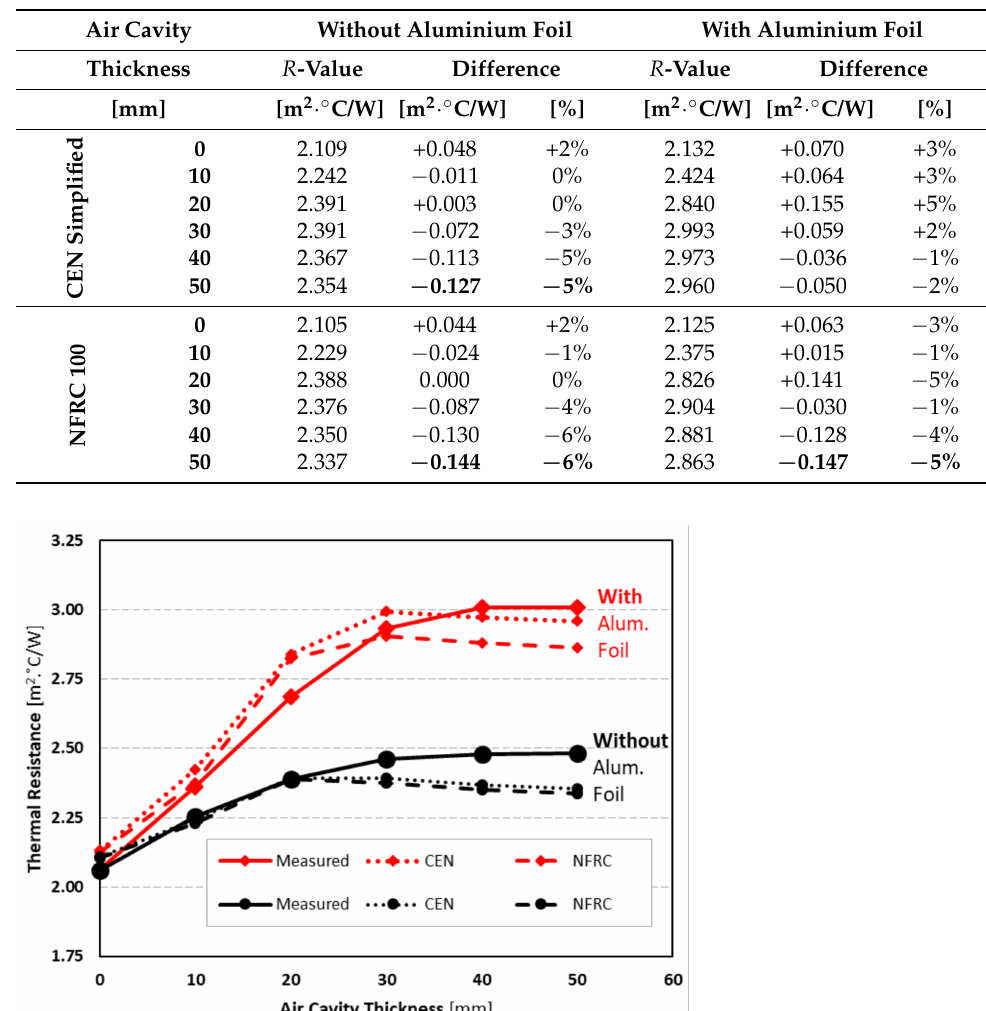
Table 3. Predicted conductive thermal resistances ( R -values) of a double pane LSF wall, with different air cavity thicknesses, with and without a reflective aluminium foil, and the thermal resistance difference to the measured values.